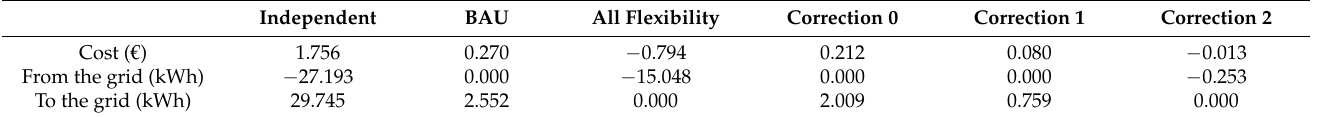
Table 3. Energy costs and balance in the EC for different scenarios in DR event at 11 a.m. Independent BAU All Flexibility Correction 0 Correction